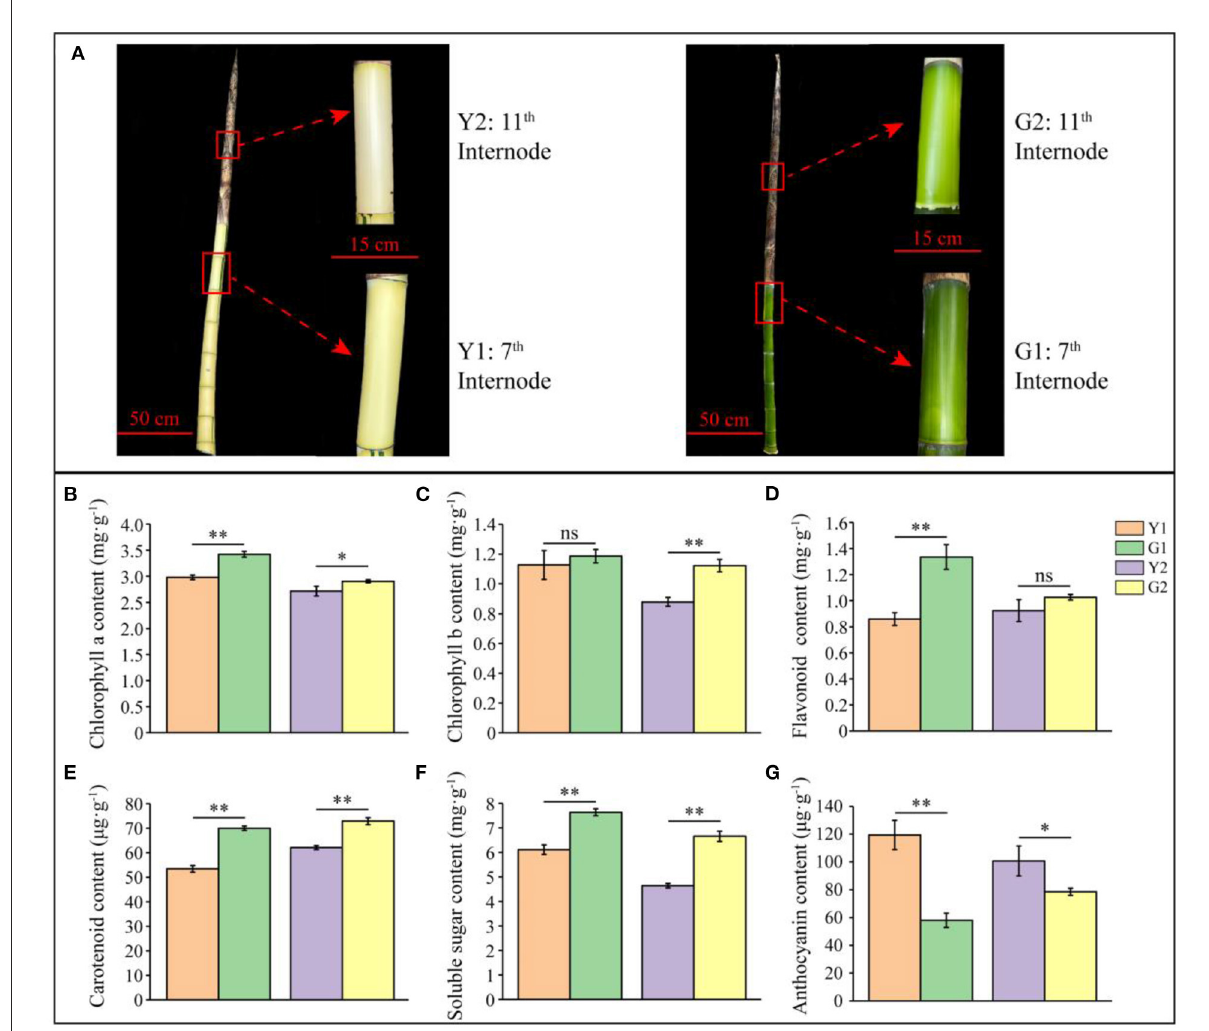
FIGURE2 Phenotype and biochemical characteristics of CYP and DGM shoots of P. vivax . (A) Shoot phenotype characteristics and representative internode of CYP and DGM culms. (B–G) Measurement of chlorophyll a, chlorophyll b, flavonoid, carotenoid, soluble sugar, and anthocyanin contents of CYP and DGM. Data is presented as the mean ± standard deviation. Statistical analyses were performed by student’s t -test. *0.01 ≤ p ≤ 0.05; ** p < 0.01; ns: p >